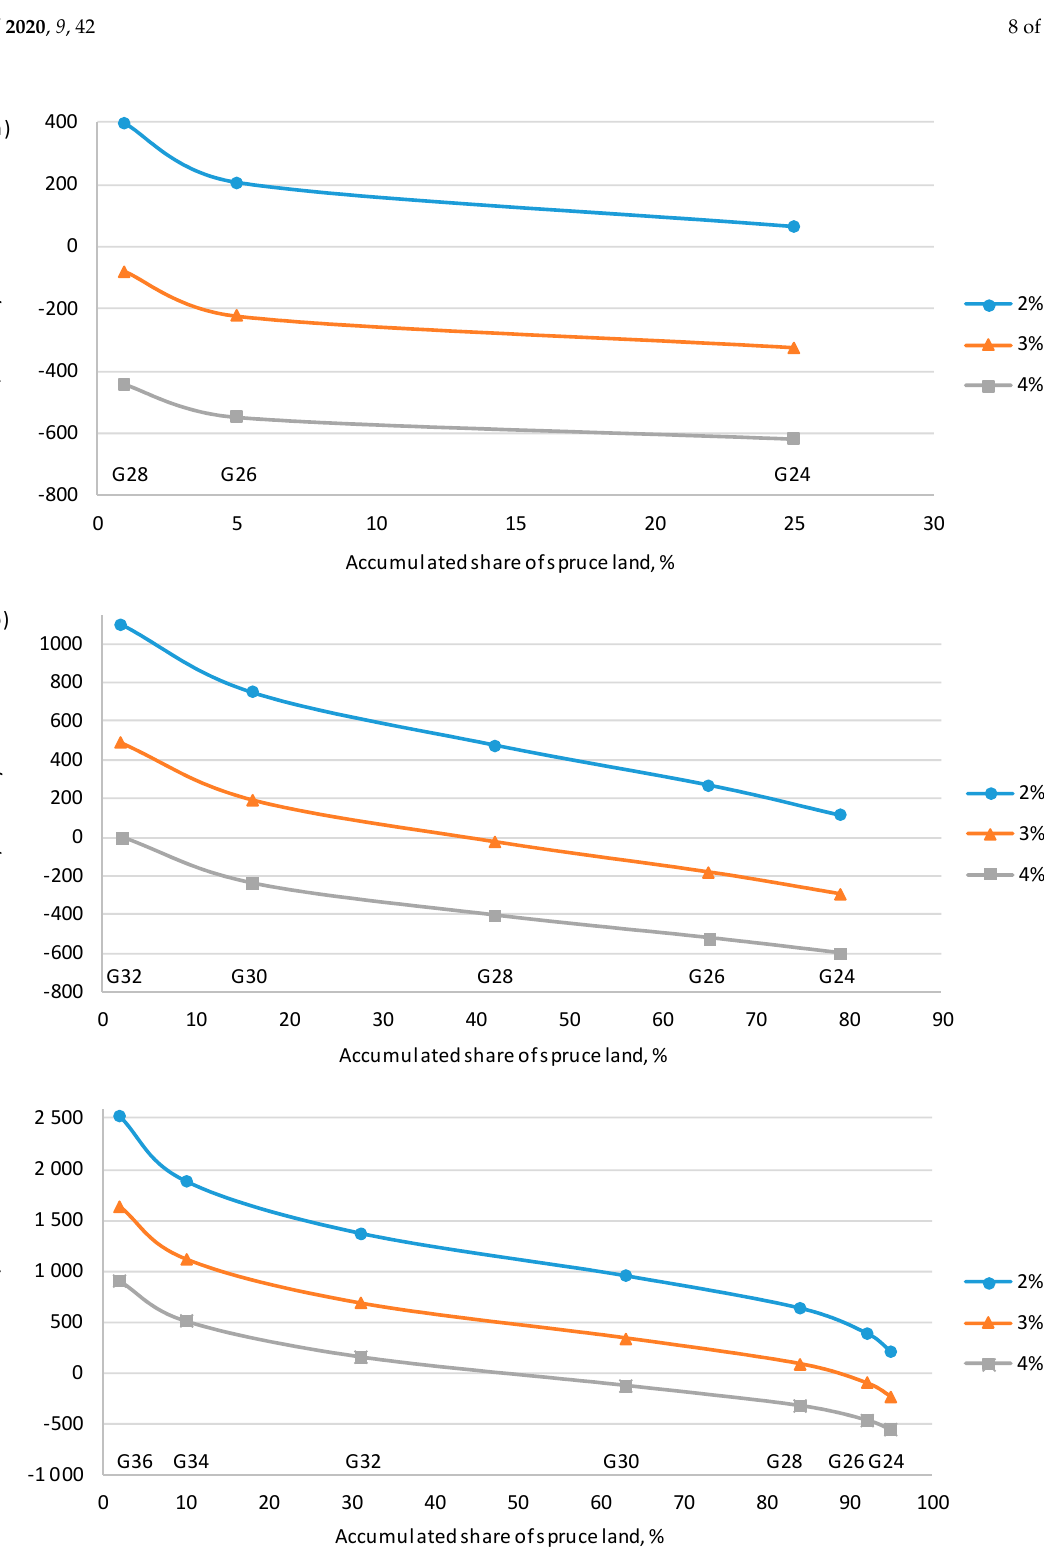
Figure 1. Annuity of net present value (ANPV) (contributions to land, management, and risk; CLM&R) of spruce plantation at site quality classes (SQC) G24–G36 using genetically improved spruce seedlings growing 15% faster than unimproved seedlings at real interest rates of 2%, 3%, and 4% in northern ( a ), central ( b ), and southern ( c ) Sweden. The x-axis indicates the accumulated share (%) of the existing spruce land in each region according to [67]. For (a) the remaining 75% of spruce land is SQC < G24.